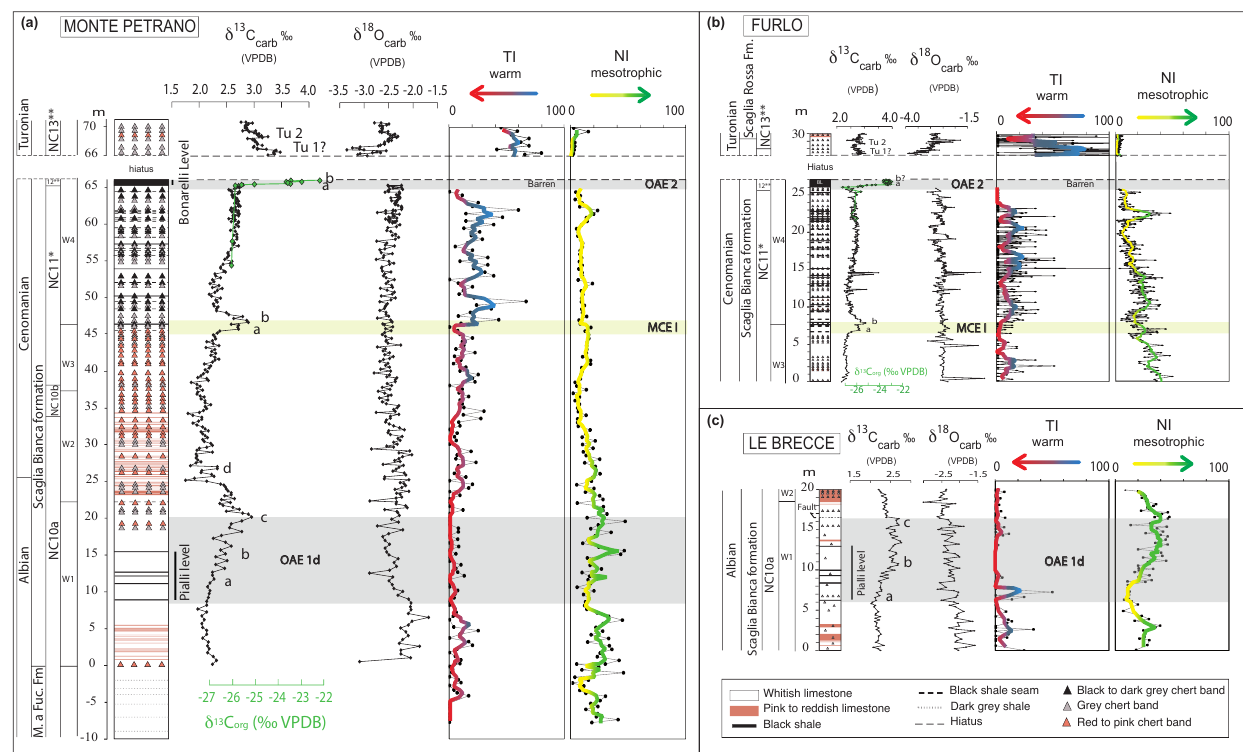
Figure 5. Nannofossil temperature (TI) and nutrient (NI) indices for the (a) Monte Petrano, (b) Furlo and (c) Le Brecce sections. TI and NI are reported point by point (in black) and smoothed (TI: blue–red; NI: green–yellow). The TI and NI were smoothed using a 3-point moving average for Monte Petrano, a 5-point moving average for Le Brecce, a 6-point moving average for the interval 0–5.8m of Furlo and an 11-point moving average for the interval 6–30m of Furlo. Lower values of the TI indicate higher temperatures and vice versa. Higher values of the NI indicate higher surface water productivity and vice versa. Lithostratigraphy, biostratigraphy and chemostratigraphy are from Gambacorta et al.